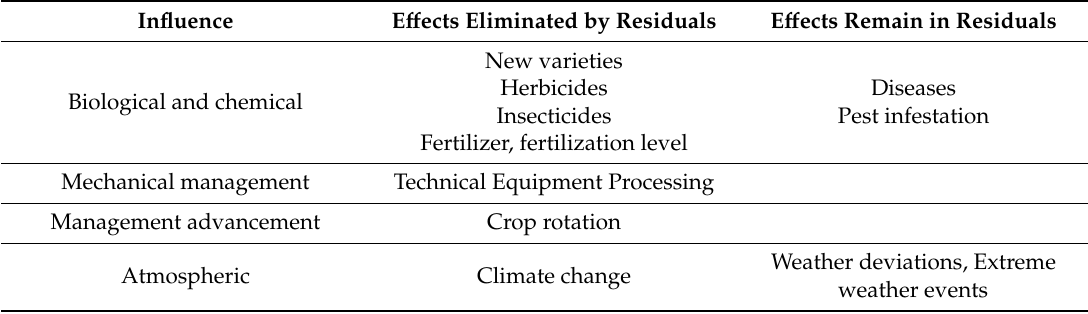
Table 5. Overview of the e ff ects on the temporal yield development and the e ff ects that are eliminated by calculating